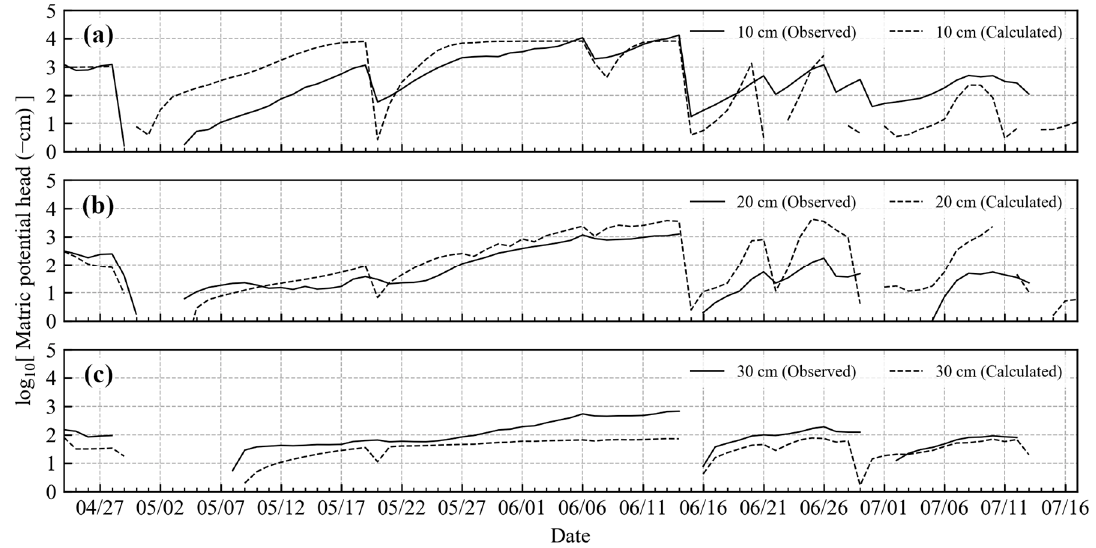
Figure 7. Matric potential head in the calibration plot in 2019. ( a – c ) Results at depths of 10, 20, and 30 cm, respectively. Those results were converted from observed and calculated volumetric water content by using calibrated Mualem–van Genuchten parameters (Table 5). We excluded data that showed positive values.